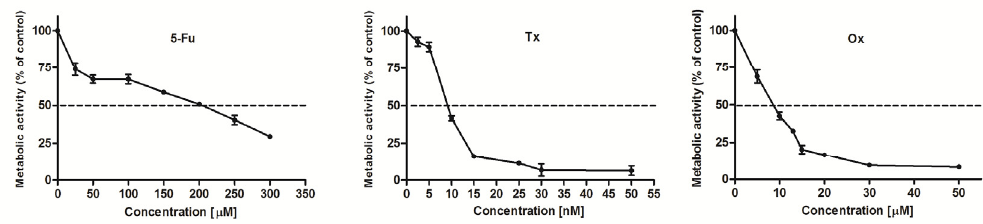
Figure 7. Metabolic activity of HL-60 cells treated with various concentrations of 5-Fu, Tx, or Ox for 24 h, analyzed by MTT assay.